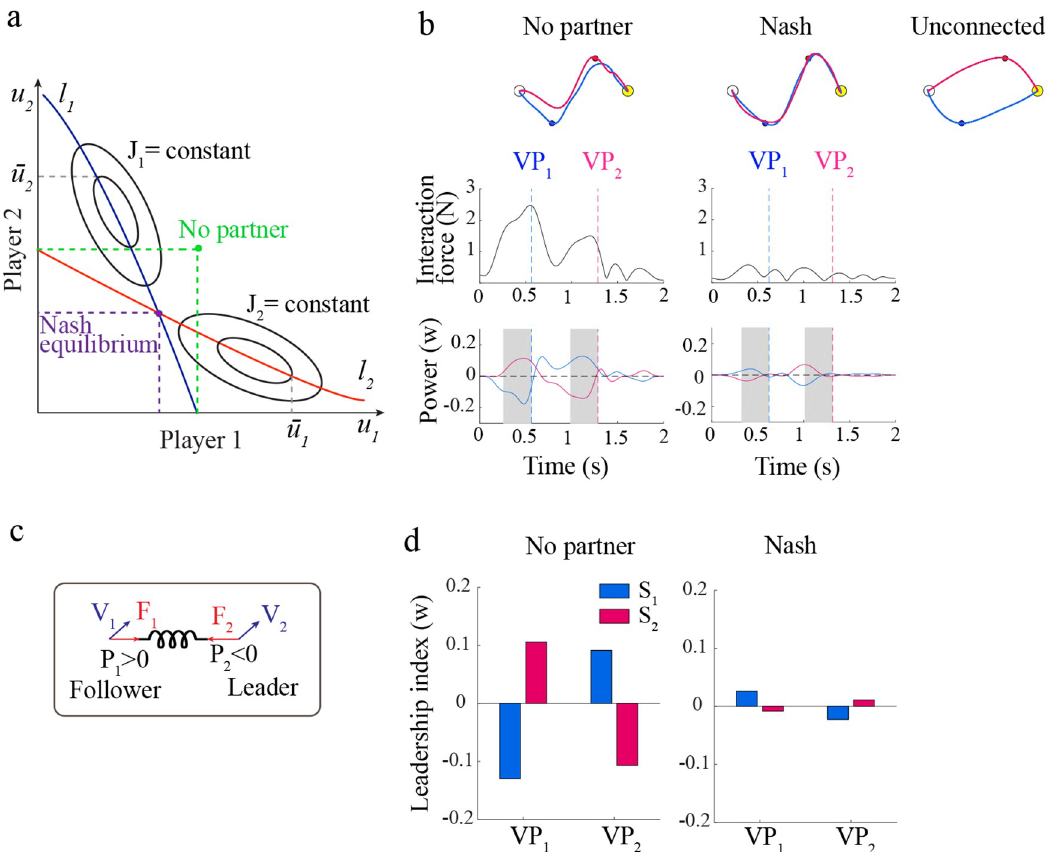
Fig 3. Predictions based on game theory. (a) Definition of Nash equilibria vs ‘no-partner’ strategies in two-players non-cooperative game. Nash equilibrium is determined by the intersection of the partners’ reaction curves—locus of optimal control action calculated for each value of the partner action [29] (blue and red lines). The ‘no-partner’ solution is determined as the optimal action calculated by each player by assuming that partner’s control is zero. (b) Simulated movements under Nash equilibria, ‘no-partner’ and unconnected conditions, for Player 1 (blue) and Player 2 (red). From top to bottom: movement paths, interaction force and , is defined as the scalar product of the interaction force ( F ) and the velocity( V ). interaction power profiles. (c) Interaction power, P i i i (d) Leader-follower strategy in the no-partner (left) and Nash strategy (right). The plots depict the Leadership index (LI) for both players and both via-points, calculated as the average power in the 300 ms interval (in gray) just before crossing the via-point by its homologous